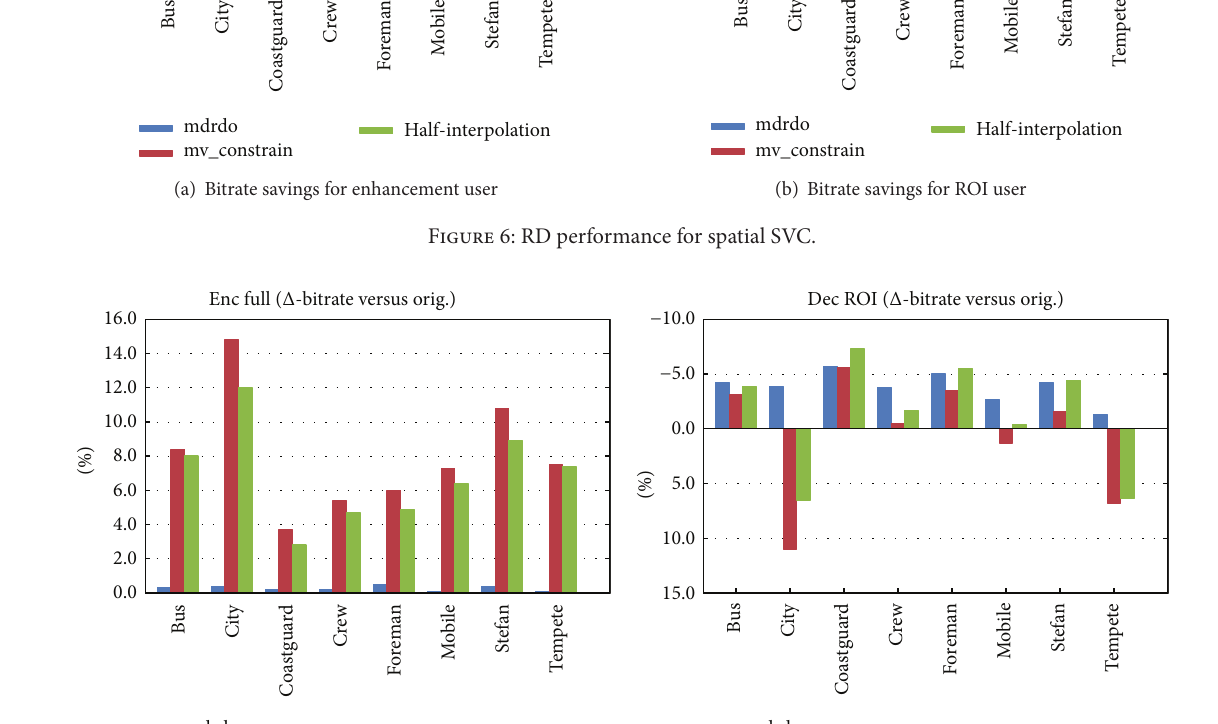
Figure 7: RD performance for quality